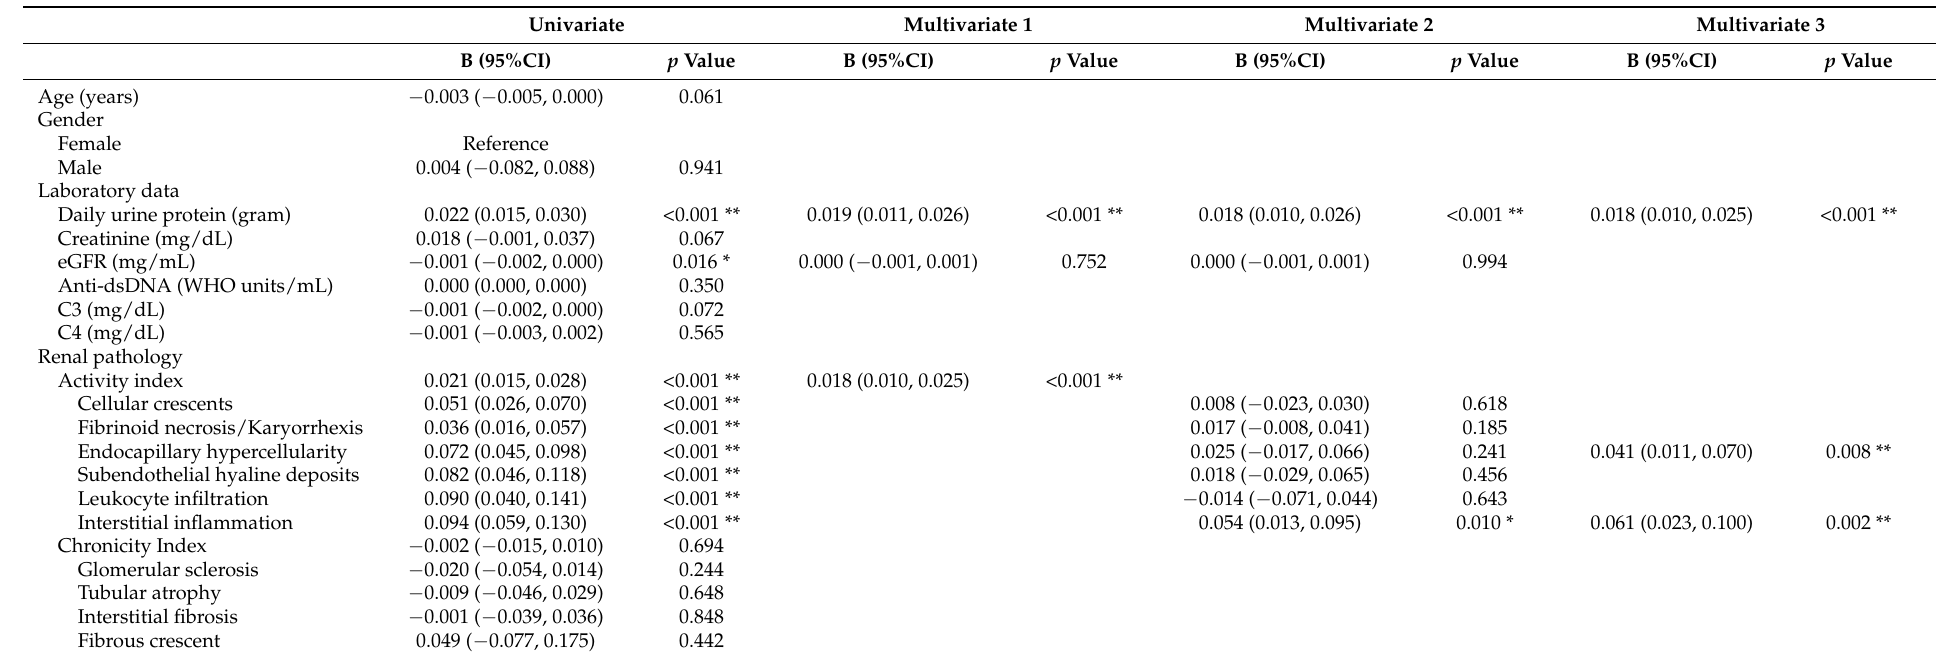
Table 2. Linear regression of clinical and histological parameters associated with left K/S